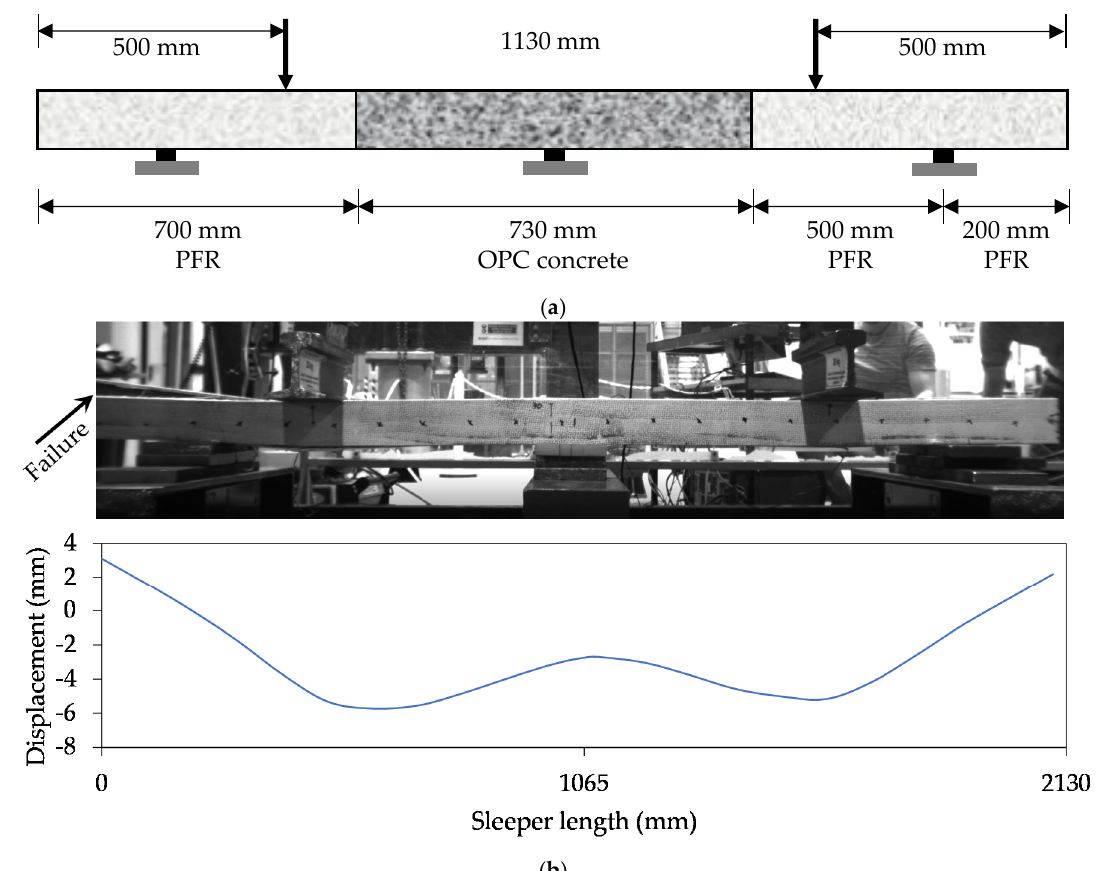
Polymers 2021 , 13 , x FOR PEER REVIEW